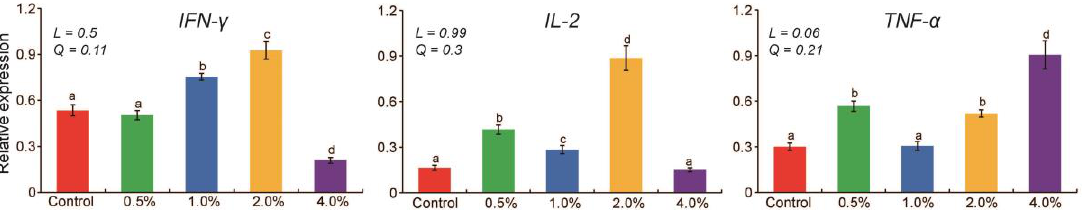
Figure 1. Effect of yeast culture supplementation in goose diets on immune gene expression. Means with different letters differ significantly ( p < 0.05). Orthogonal contrasts: L = linear and Q = quadratic effect of yeast culture supplementation.